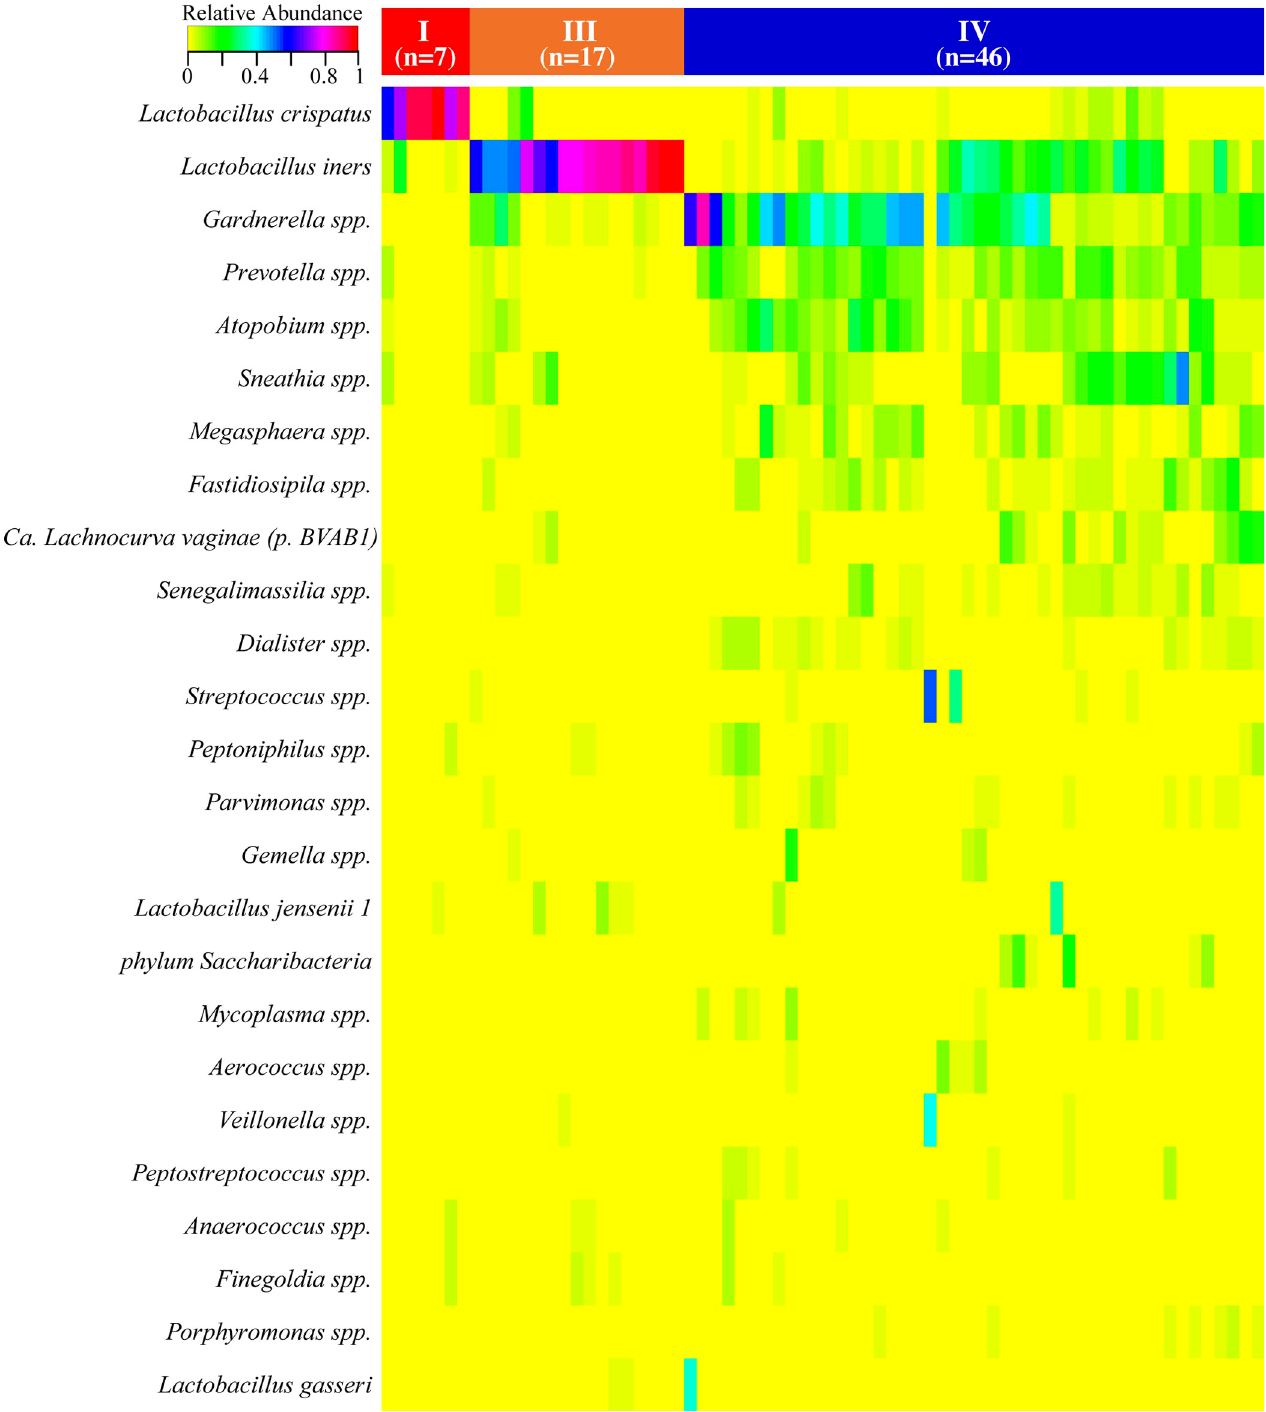
Fig 1. Heatmap displaying the relative abundance of the 25 most abundant bacterial taxa observed in the vaginal tracts of 70 American Indian women.